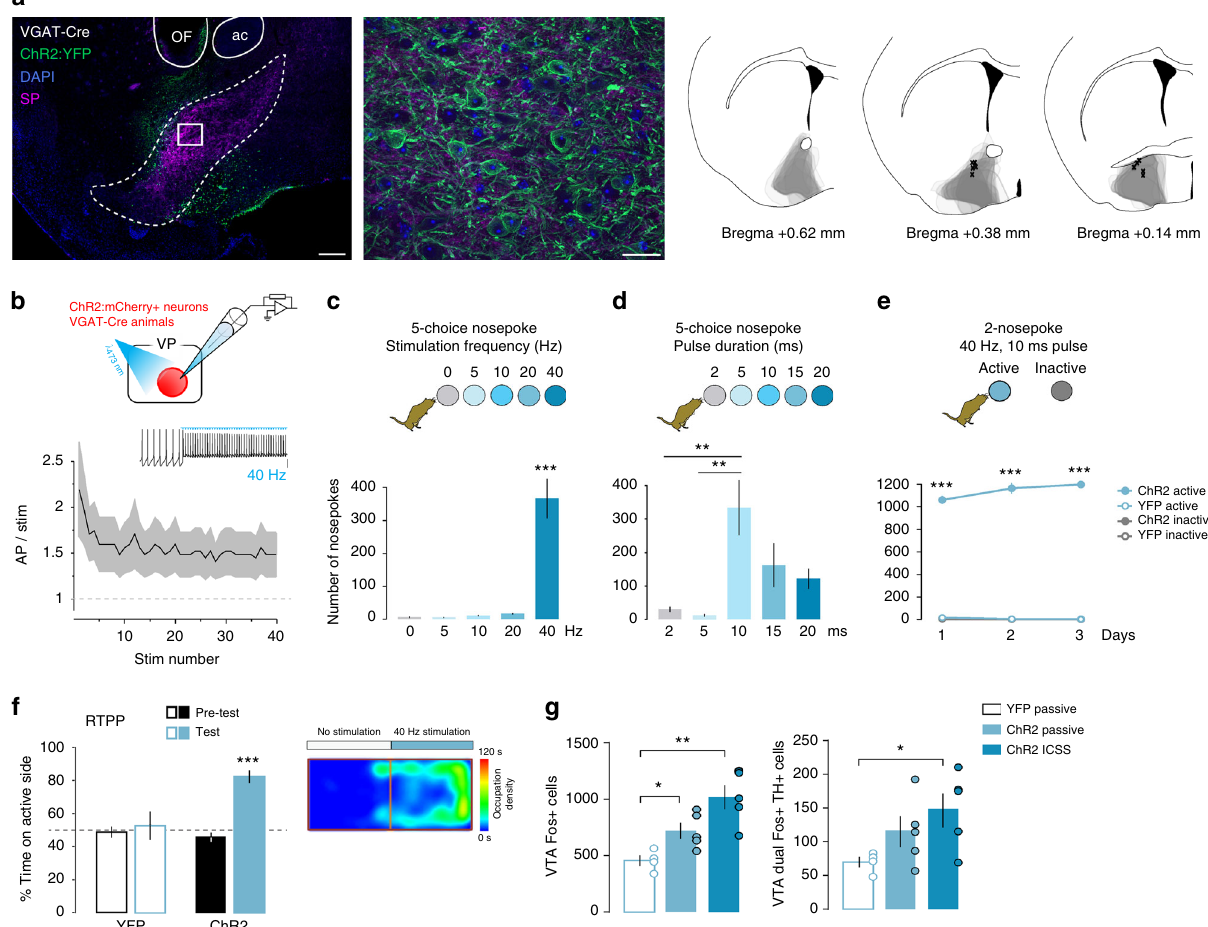
Fig. 3 Stimulation of VP GABA neurons elicits positive reinforcement. a Expression of ChR2:YFP in the VP of VGAT-Cre mouse imaged under epi fl uorescent (left, scale 200 µ m) or apotome (right, scale 20 µ m) illumination. Counterstaining with SP (purple) and DAPI (blue), ac anterior commissure, OF optic fi ber track. Spread of ChR2:YFP expression in the VP of VGAT-Cre animals (overlapped gray areas for each animal, right panel) and optic fi ber tip placements ( x marks the spot). b Firing of ChR2:mCh + VP GABA neurons in response to 40-Hz photostimulation ( n = 9 cells); SEM represented in gray. Inset shows representative trace; scale = 20 mV. c In a fi ve-choice nosepoke ICSS task for VP GABA neuron stimulation mice prefer 40-Hz stimulation ( n = 7). d When choosing between pulse durations, mice preferred 10 ms pulse width ( n = 7). e Over 3 daily 1-h two-nosepoke ICSS sessions, mice made 1141 ± 41 nosepokes for stimulation of VP GABA neurons ( n = 6 YFP controls and eight ChR2). f In an RTPP assay, mice preferred the compartment paired with stimulation of VP GABA neurons ( n = 9 YFP controls and 10 ChR2). Right panel shows occupation density of an example mouse during the test trial. g Fos + cells in the VTA increased following ICSS or passive activation of VP GABA neurons ( n = 4 VGAT YFP controls, n = 5 VGAT ChR2 passive and ICSS each). The number of VTA cells double positive for the dopamine marker TH and Fos increased following ICSS for VP GABA neuron activation. * p < 0.05, ** p < 0.01, *** p < 0.001. See also Supplementary Figures 5 and